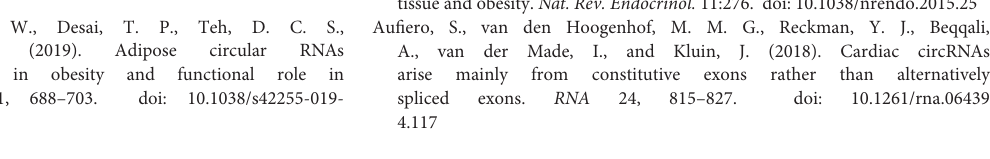
Supplementary Table 7 | Prediction of circRNA-miRNA